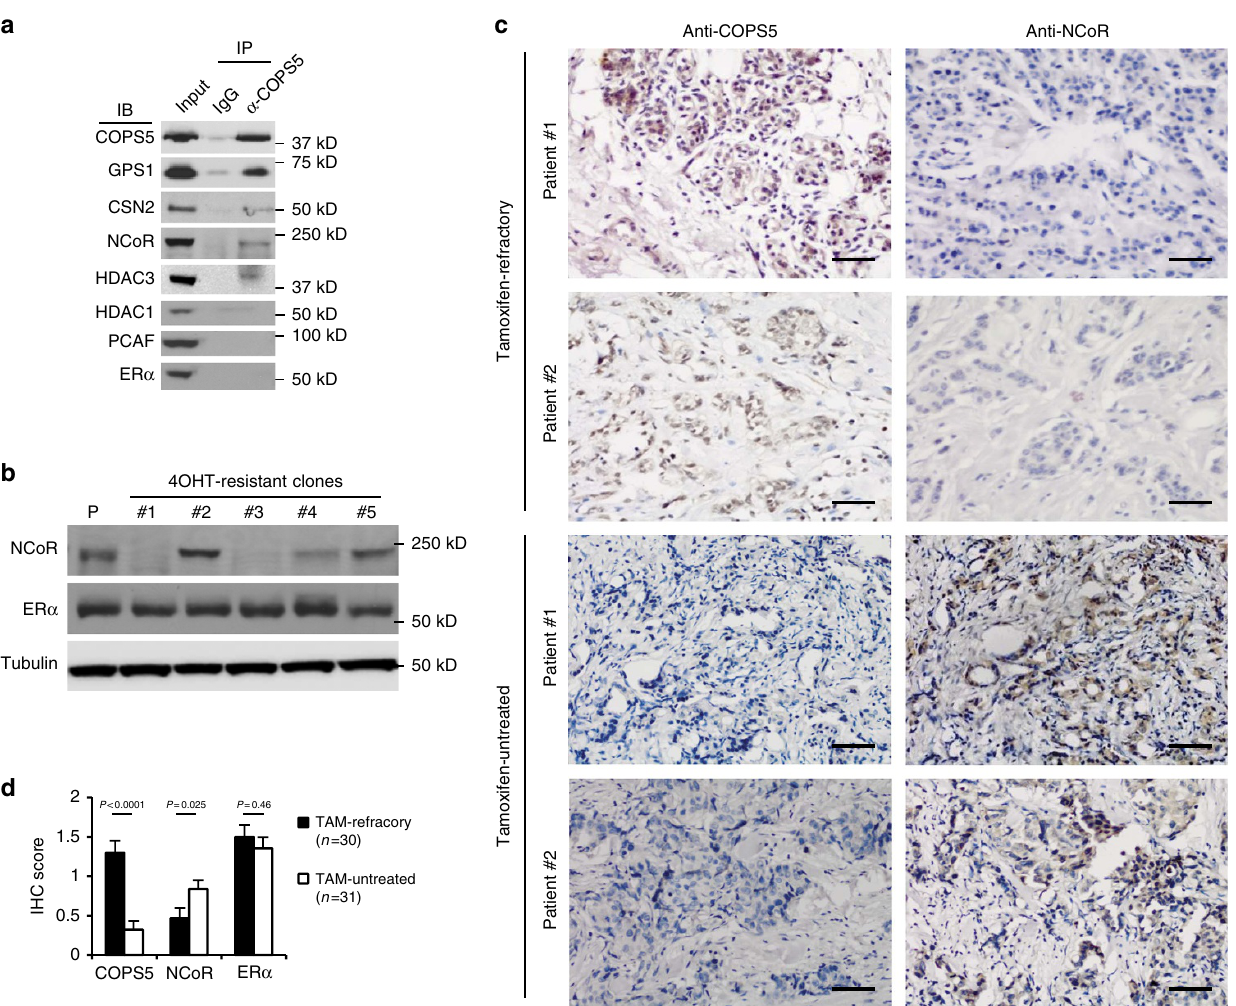
Figure 3 | NCoR protein is downregulated in COPS5-overexpressed breast cancer cells. ( a ) Western blot analysis of proteins that were co- immunoprecipitated with anti-COPS5 antibodies in MCF7 parental cells. ( b ) Western blot analysis of NCoR and ER a expression in parental and tamoxifen-resistant MCF7 clones. P, parental cell line. ( c ) IHC of NCoR and COPS5 expression in representative tamoxifen-untreated and refractory breast cancer samples (scale bar, 50 m m). Anti-COPS5 and anti-NCoR antibodies showed nuclear and nuclear/cytoplasmic staining in tumor cells, respectively. ( d ) Quantification and statistical analysis of IHC staining of COPS5, NCoR and ER a in tamoxifen-untreated and refractory breast cancer